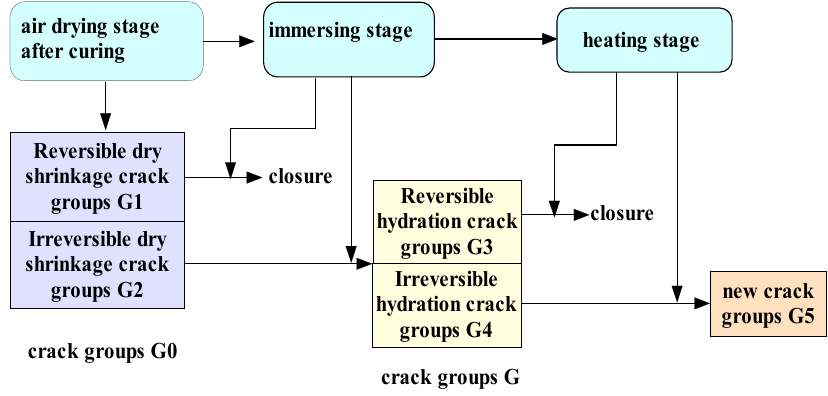
Figure 13. Schematic of crack evolution .